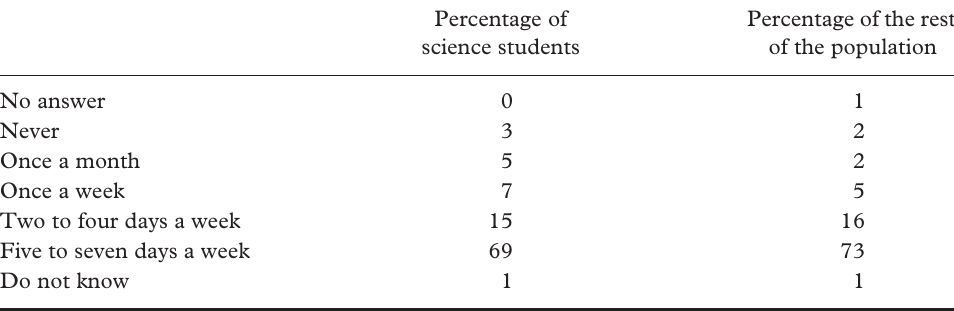
Table 1. IM use frequency of science students, compared with the rest of the population